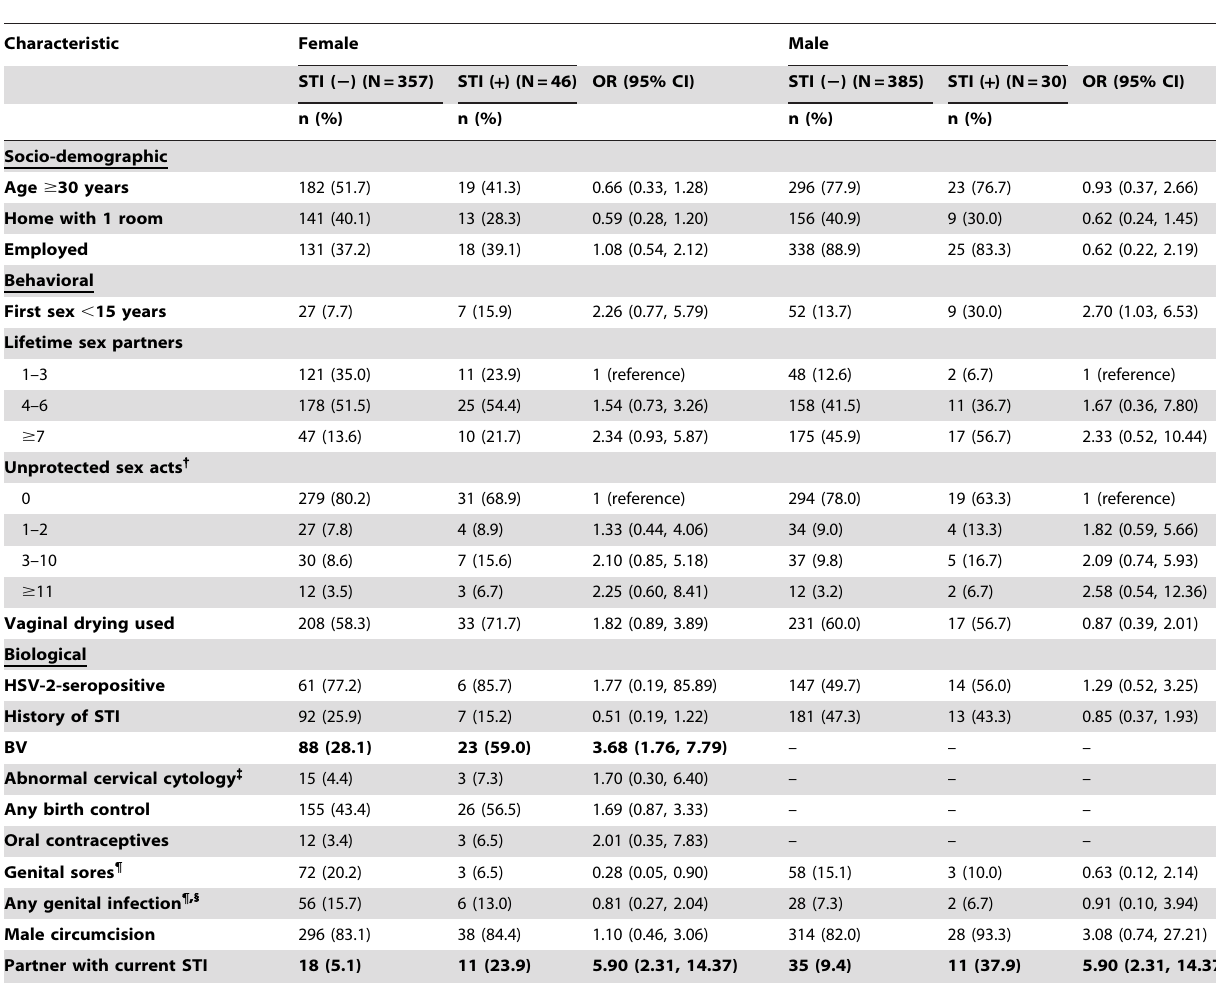
Bold indicates significant associations controlling the false discovery rate at 5% based on the Benjamini-Hochberg method. * Positive laboratory result for syphilis, gonorrhea, chlamydia, or